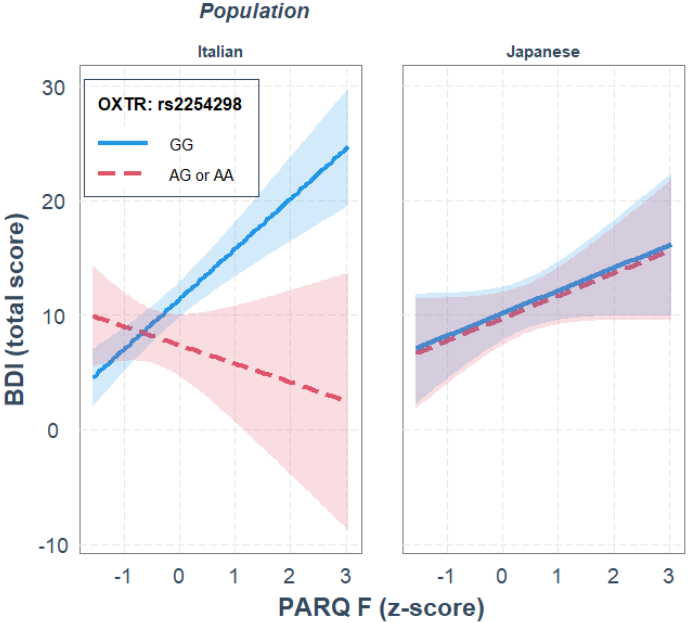
Figure 3. Single regression analyses predicting depression (BDI) from remembered paternal rejection as a function of OXTR rs2254298 gene polymorphisms and population.